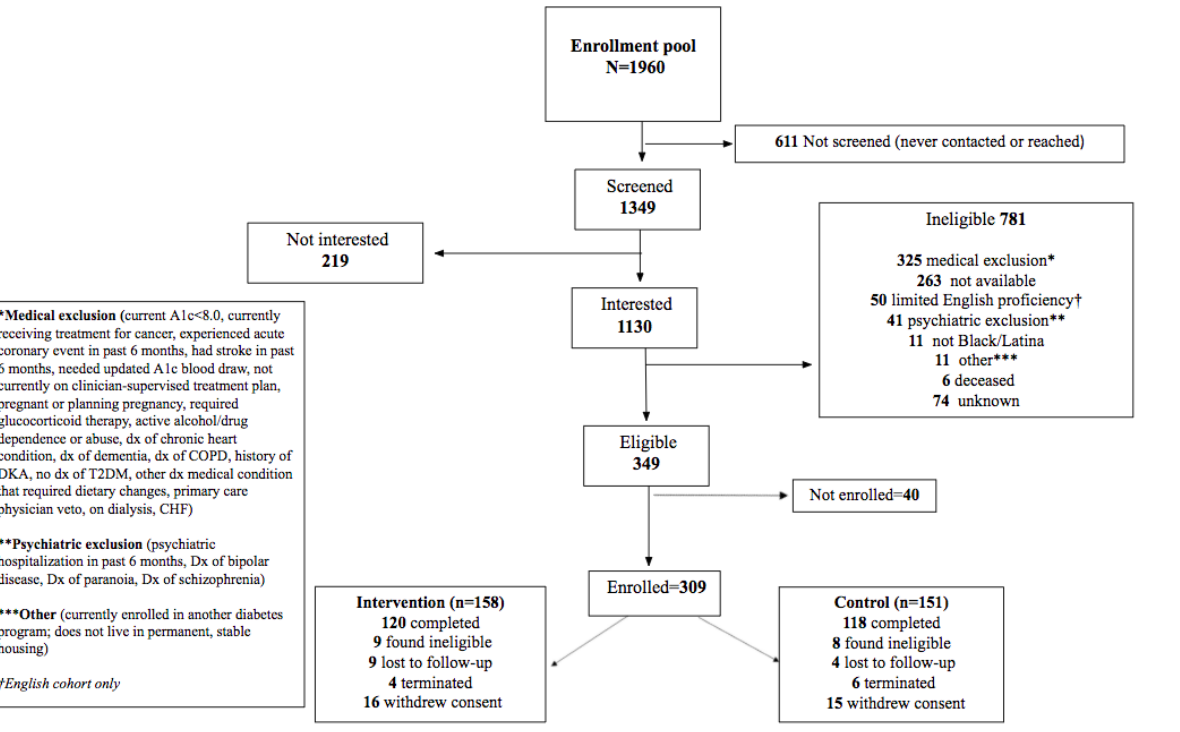
Figure 1. Women in Control 2.0 Consolidated Standards of Reporting Trials (CONSORT) diagram. CHF: congestive heart failure; COPD: chronic obstructive pulmonary disease; DKA: diabetic ketoacidosis; dx: diagnosed with; T2DM: type 2 diabetes